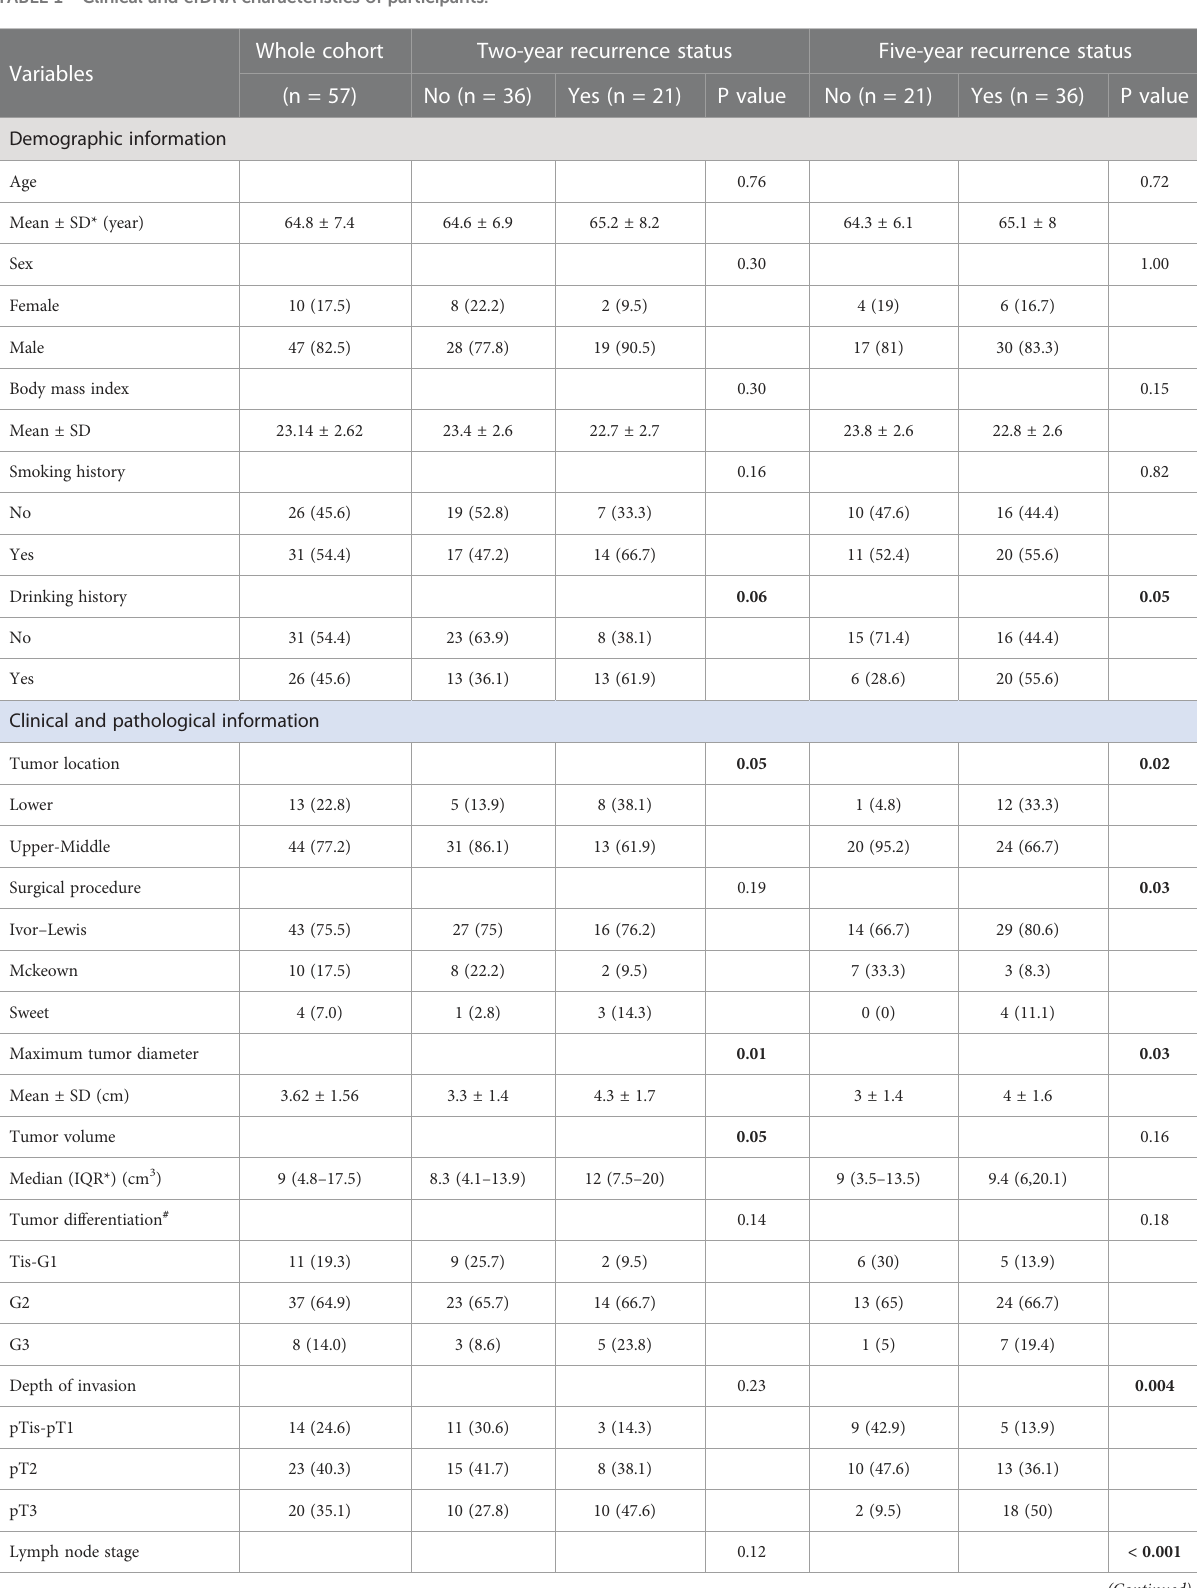
TABLE 1 Clinical and cfDNA characteristics of